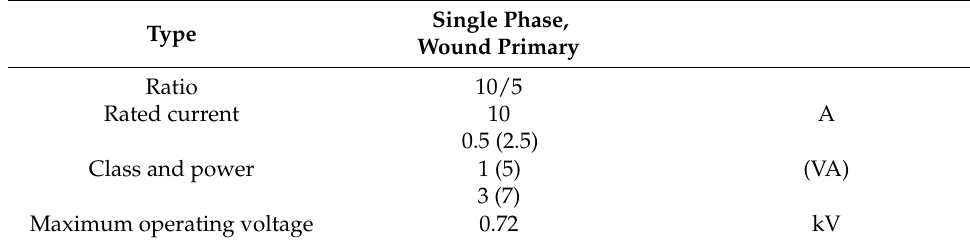
Table 5. Current transformer data.